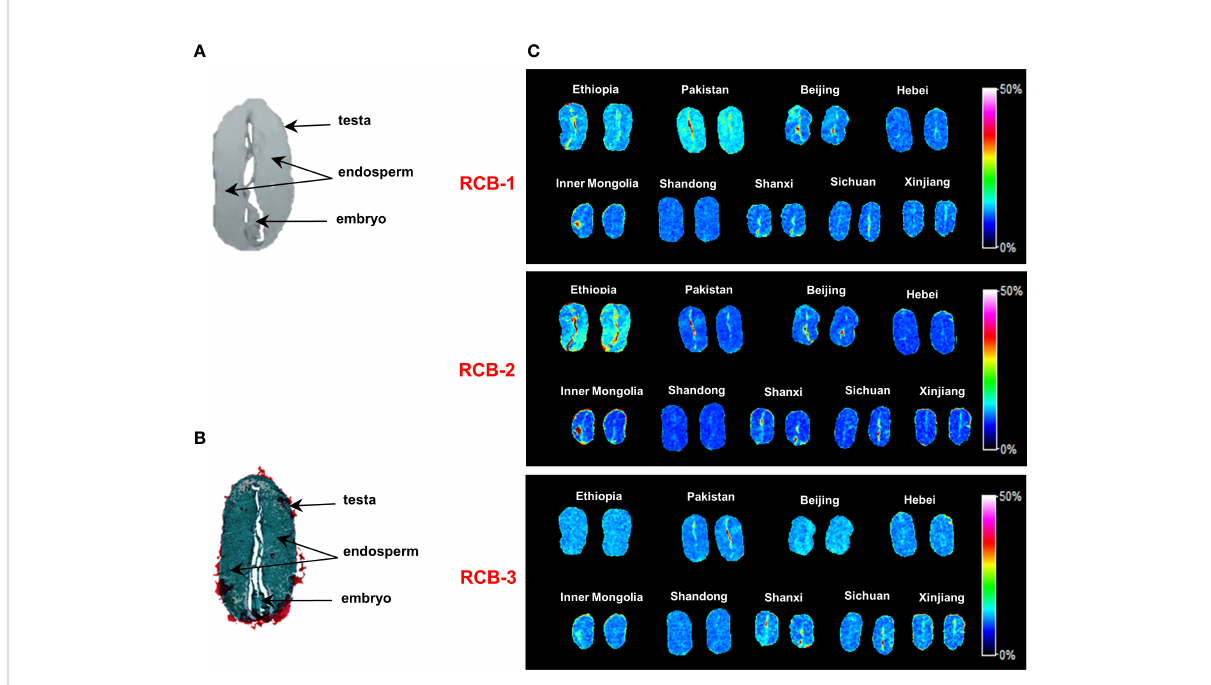
FIGURE 4 MALDI-MSI analysis of RCBs in positive ion mode in castor bean sections. (A) Optical imaging of the castor bean structure; (B) Saffron O-fast green plant tissue staining; (C) Distribution of RCB-1, -2 and -3 in castor beans from geographical sources. Color scales encode arbitrary ion relative